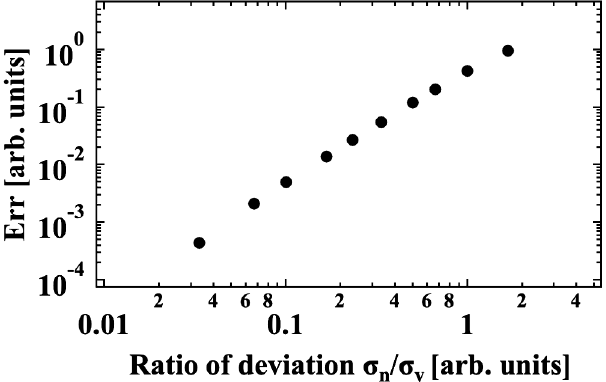
FIG. 4. The error between g ð 0 ; y Þ and f ð 0 ; y Þ against the thickness ratio of the gas sheet distribution and the beam distribution in the y